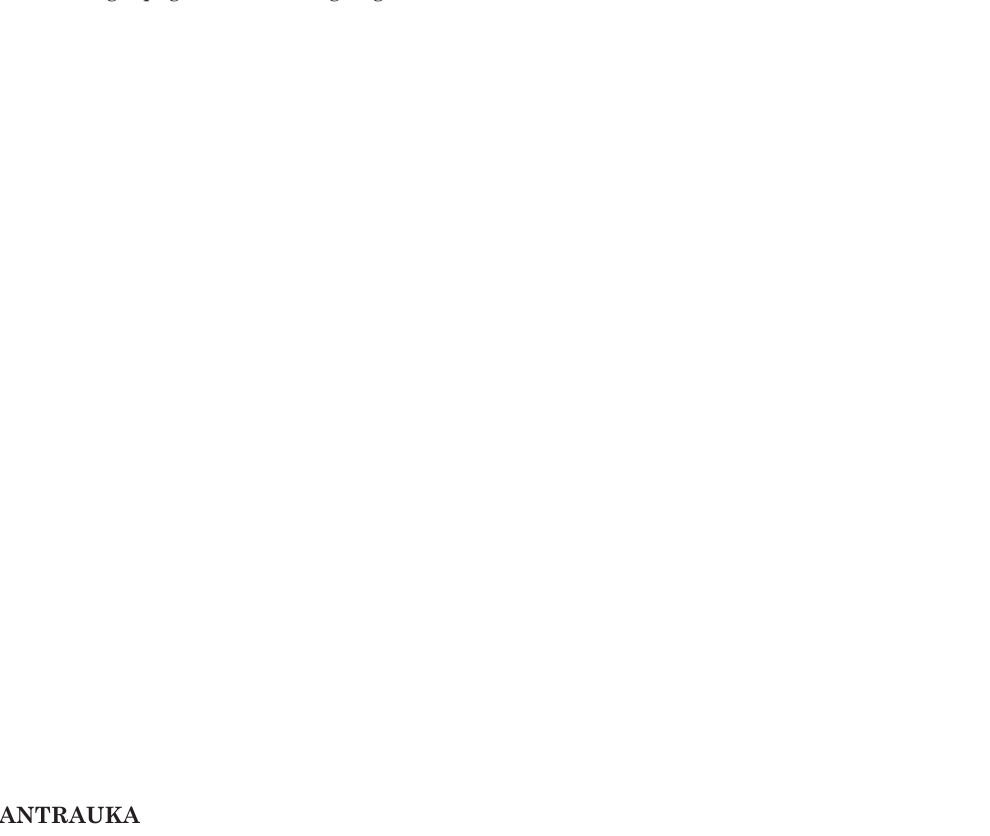
sunkiau atlikti empiriškai pagrįstą būsto rinkos prognozę. Todėl reikalingas išsamus ir sisteminis